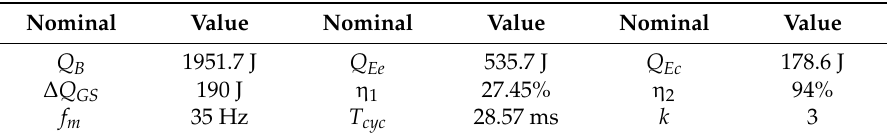
Table 3. System power and efficiency specifications.